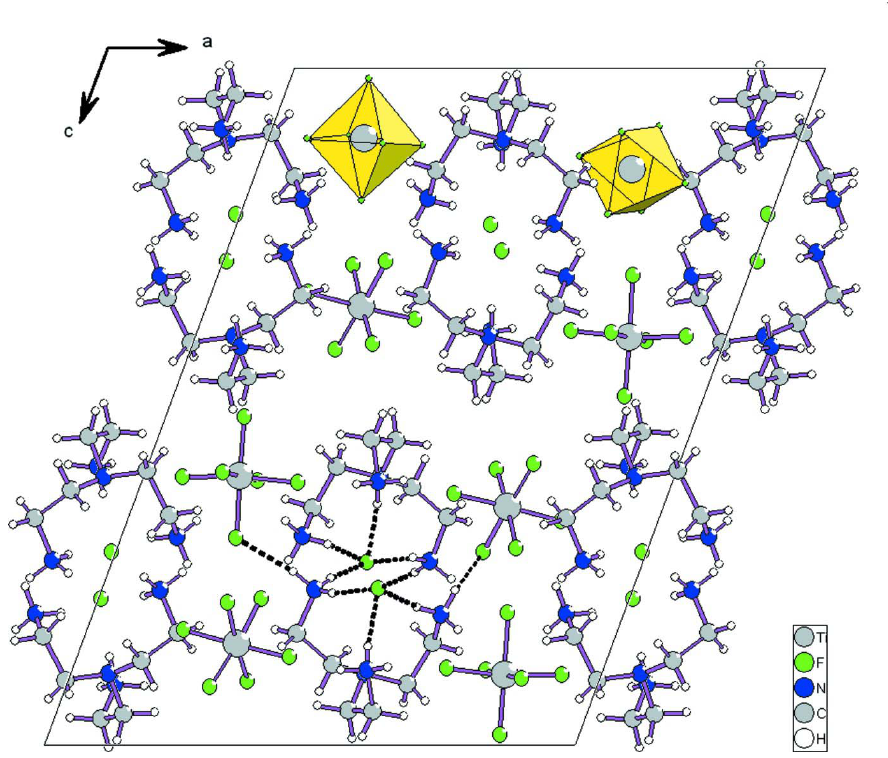
Figure 2 Crystal packing of (I) with view along [010]. Hydrogen bonding is shown as dashed